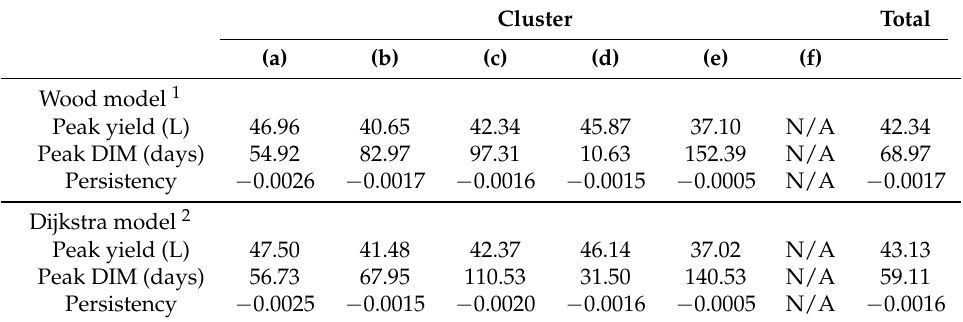
Table 6. Peak yield, peak DIM, and persistency calculated using the obtained regression parameters. Cluster